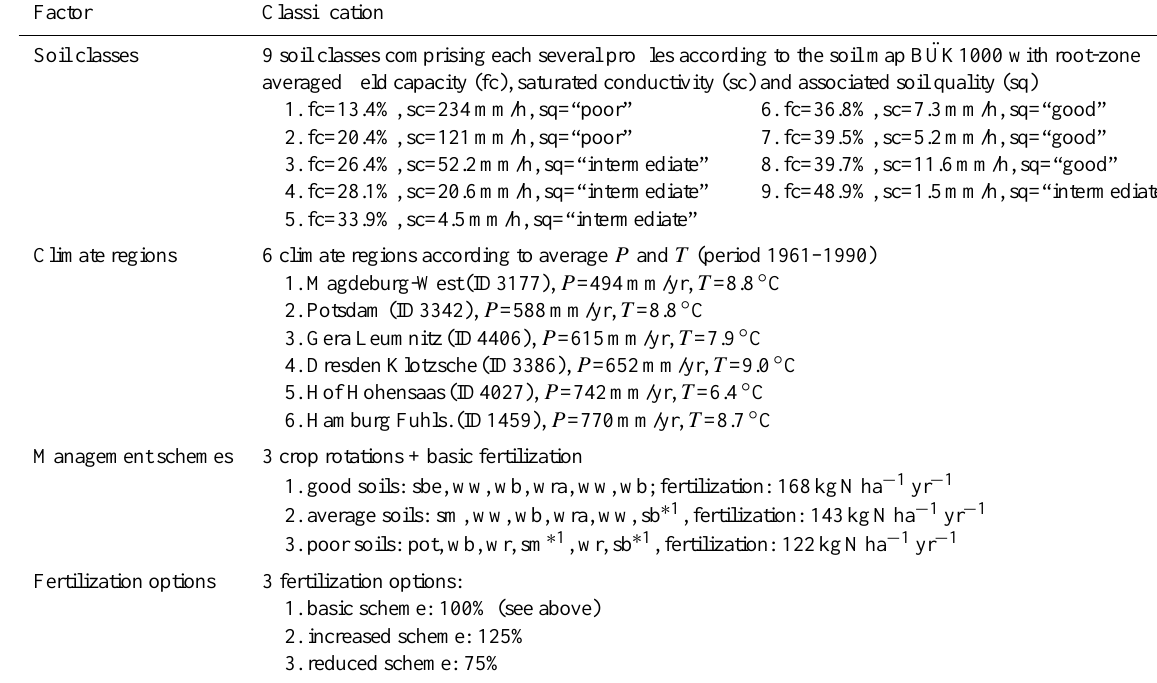
Table 3. Overview of the simulation variants. Factor